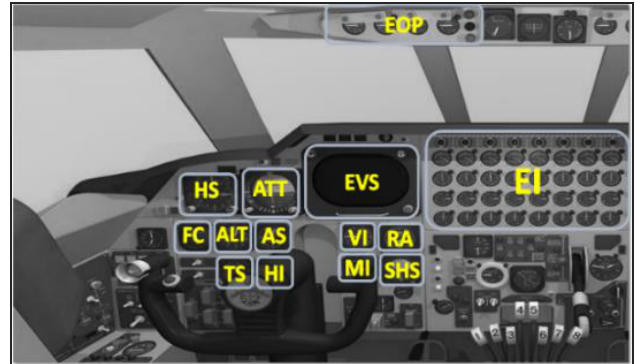
Figure 3. Context-specific AOIs that were defined based on the instrument fight rules (IFRs). The AOI names were as follows: engine oil pressure: EOP; engine indicators: EIs; enhanced visual screen: EVS; attitude indicator: ATT; horizontal situation indicator: HS; flight command indicator: FC; altimeter: ALT; airspeed indicator: AS; true airspeed indicator: TS; heading indicator: HI; vertical velocity indicator: VV; radar altimeter: RA; Mach indicator: MI; standby horizon indicator: